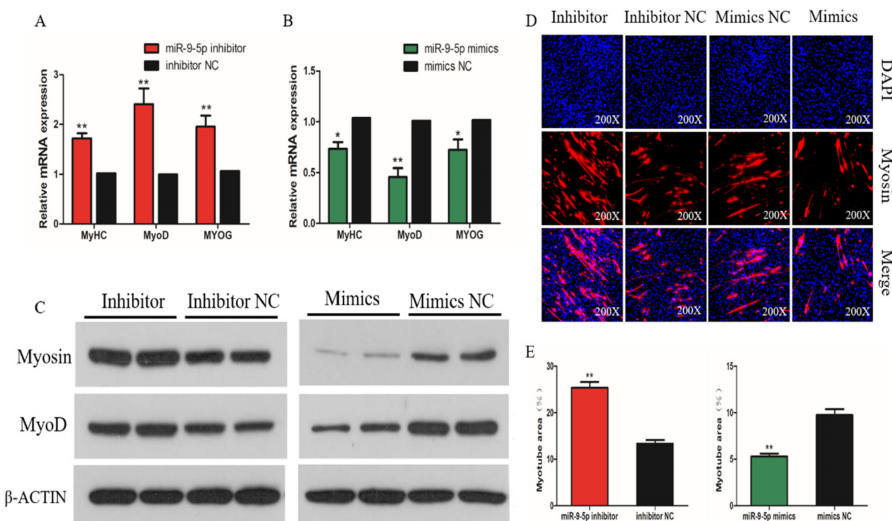
Figure 3. E ff ect of miR-9-5p on di ff erentiation of SMSCs. ( A , B ) The relative expression of myogenic determination (MyoD), myosin heavy chain (MyHC), and myogenin (MyoG) mRNA in SMSCs allowed us to di ff erentiate for 48h with miR-9-5p inhibition or overexpression. ( C ) The protein levels of myogenic marker genes after the inhibition and overexpression of miR-9-5p, from Western Blot. ( D ) Representative images of immunofluorescent staining of di ff erentiated SMSCs (200x magnification). Myosin: red, a molecular marker of myogenesis; DAPI: blue, cell nuclei; Merge: the fusion of SMSCs into primary myotubes. ( E ) The myotube area (%) after the transfection of miR-9-5p mimics, miR-9-5p inhibitor, or NC. The data are expressed as mean ± SEM ( n = 6). * p < 0.05; ** p < 0.01 vs. NC.